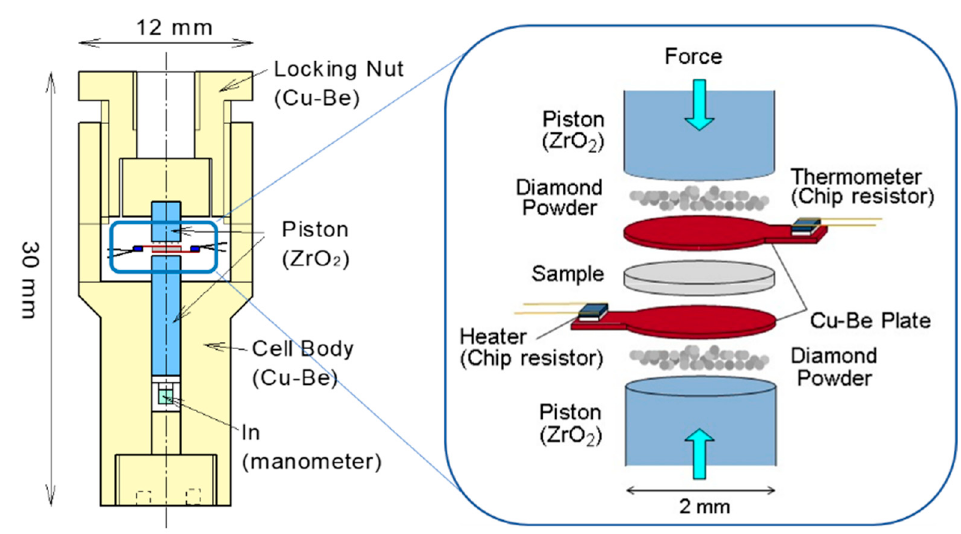
Figure 2. Schematic drawing of the ac calorimeter under uniaxial pressure.